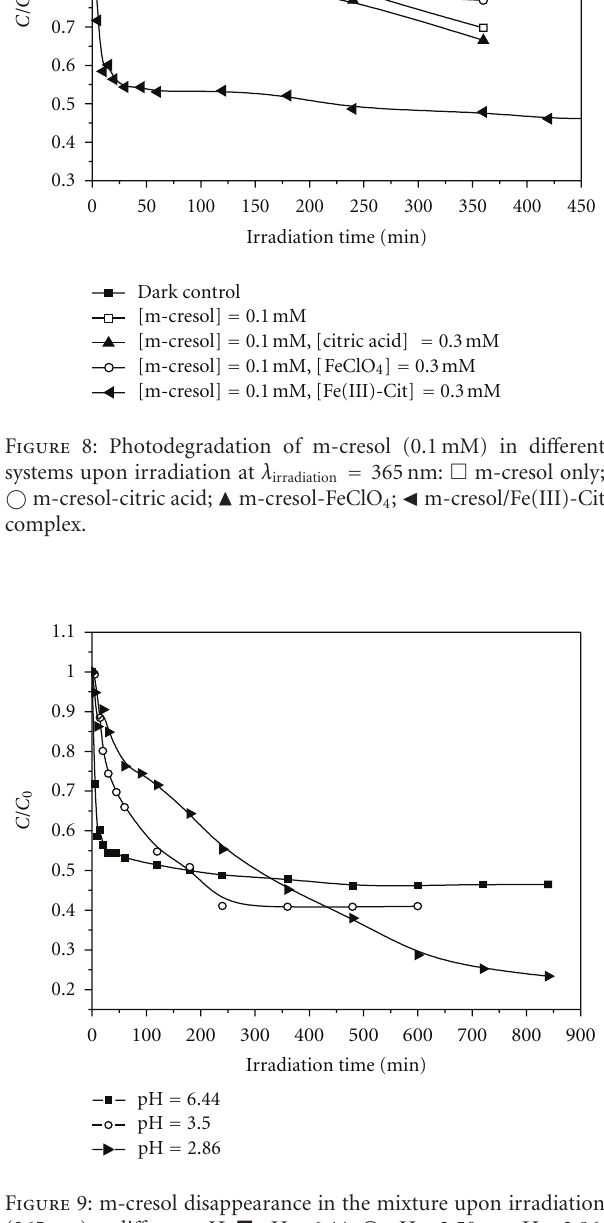
higher pH value, the concentration of iron species was slower (Figure 10).